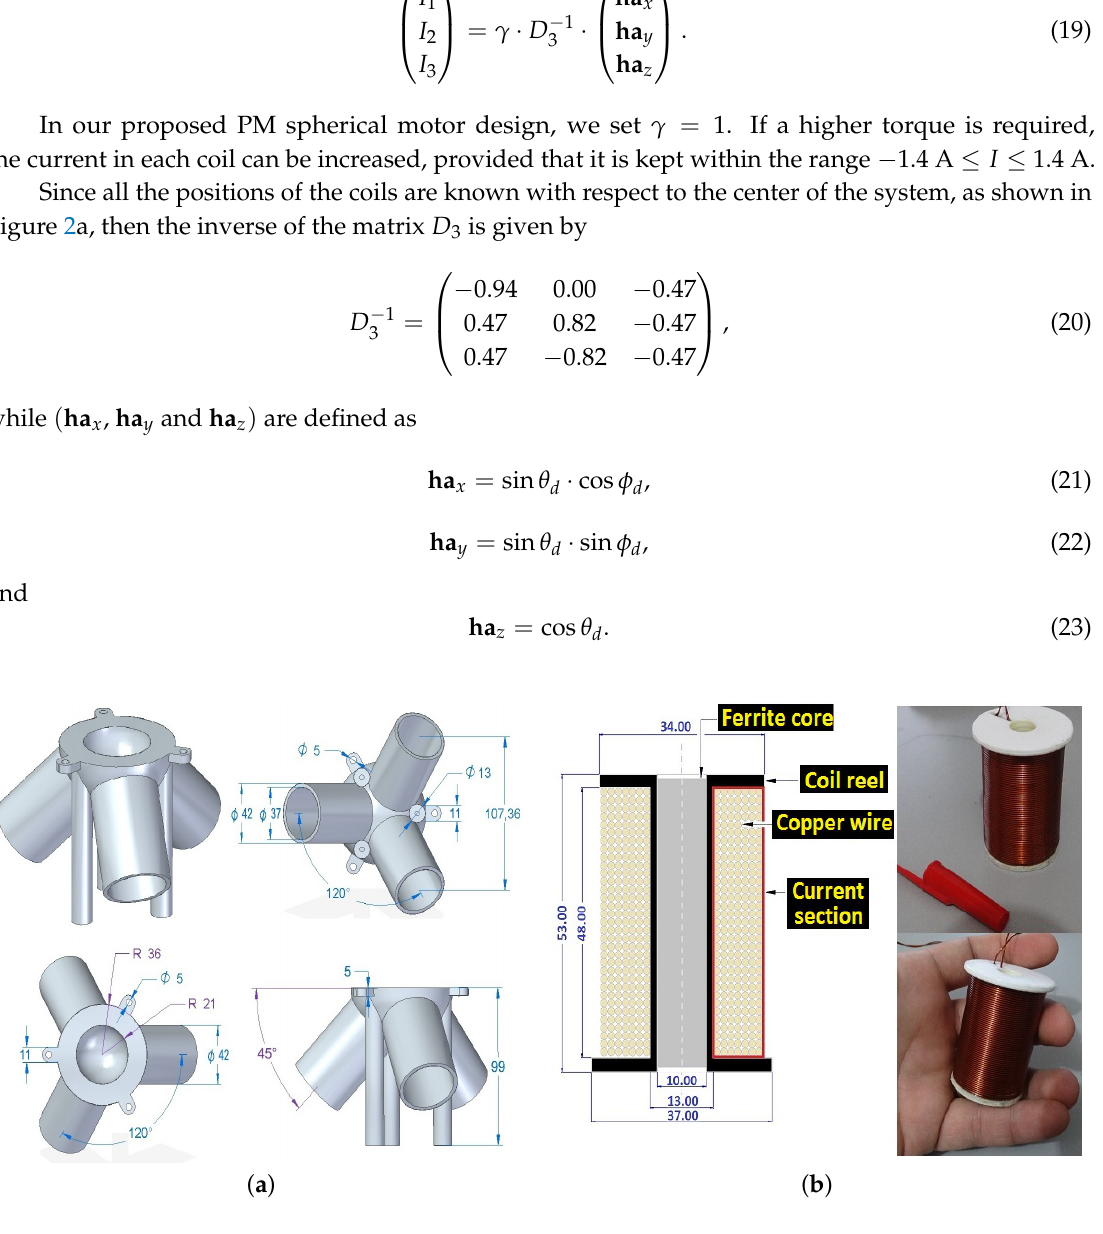
Figure 2. ( a ) Dimensions of the proposed stator in (mm); and ( b ) coil without ferrite core, dimensions in